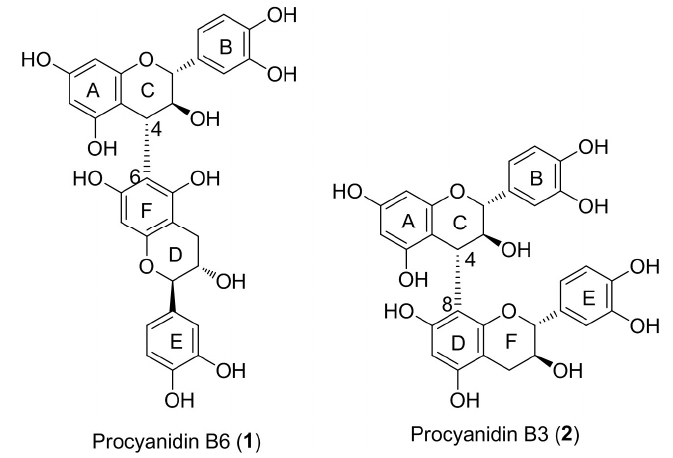
Figure 1. Structures of procyanidin B6 ( 1 ) and procyanidin B3 ( 2 ).